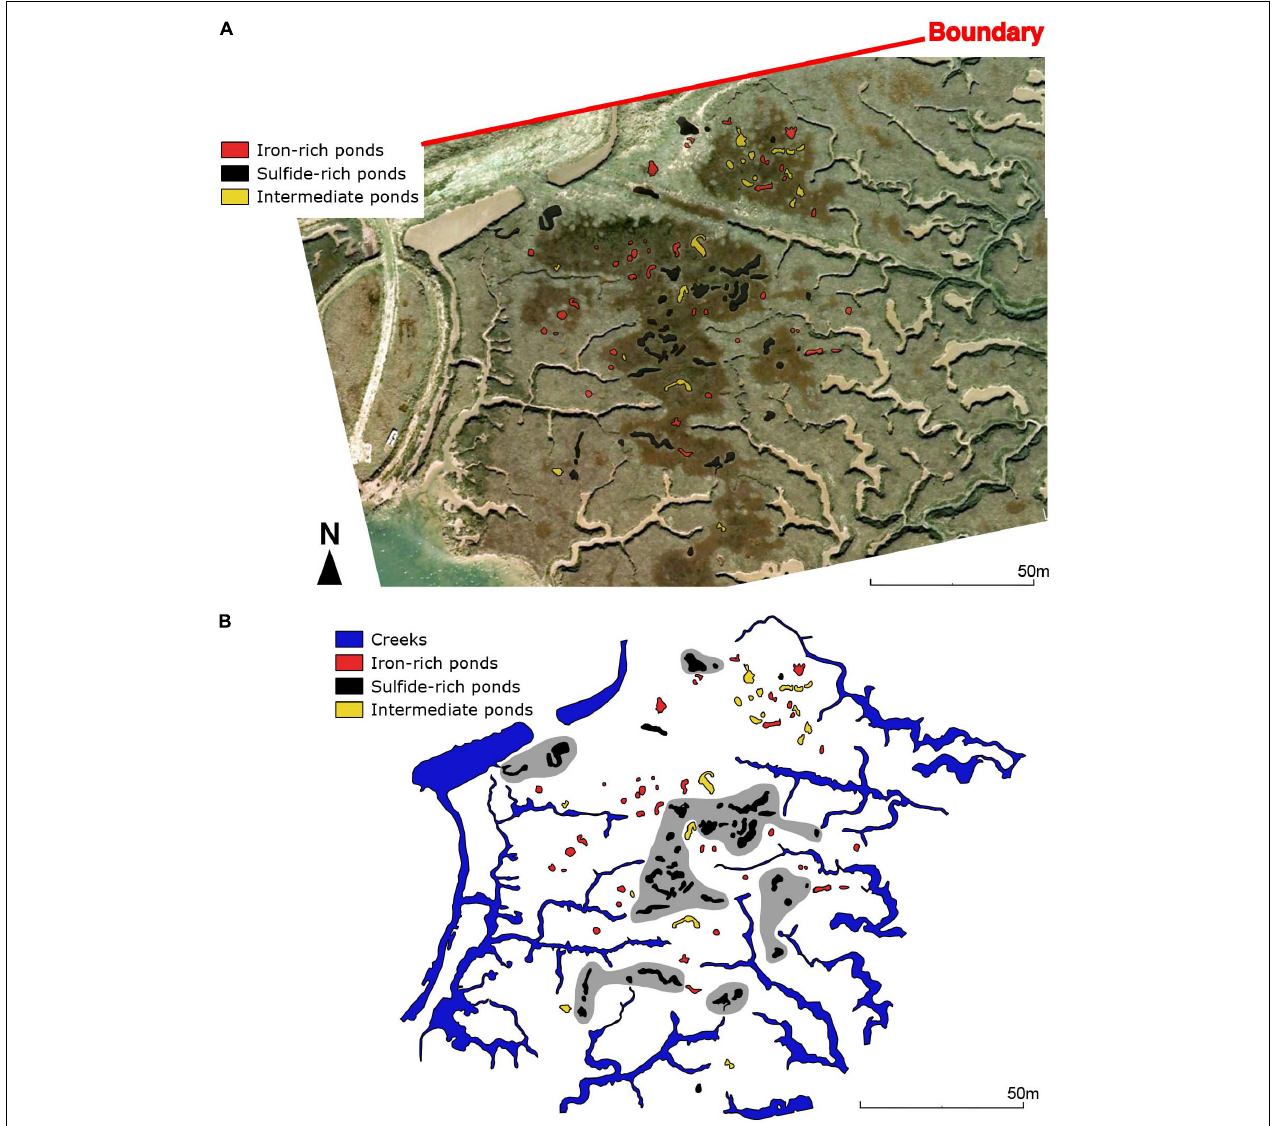
FIGURE 9 | (A) Google Earth imagery (06/11/2006) of the salt marsh system in Abbotts Hall (Area 3) ( Figure 1G ) overlain by geochemical classification observed in June 2018. (B) Geochemical classification with hypothetical, hand-drawn zones of sulfide-rich pond clustering shown in gray. Boundary depicted on panel (A) corresponds to landward extent of the salt